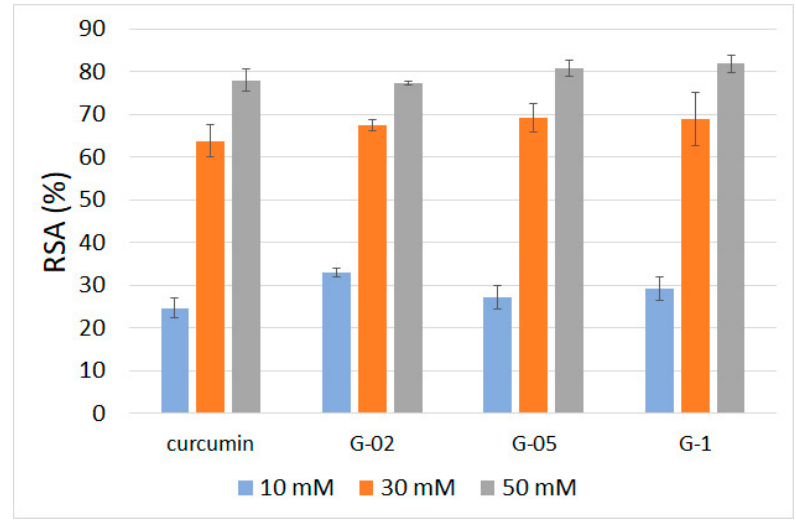
Figure 10. Antiradical activity, expressed as % RSA, of the different samples and pure curcumin